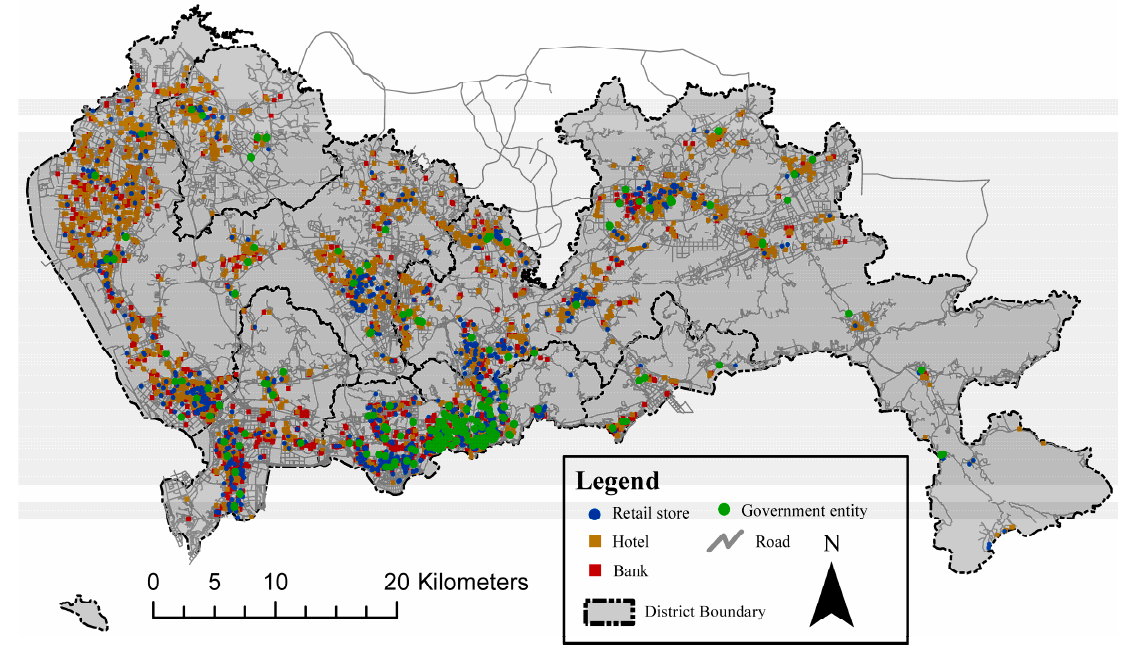
Figure 5. The study region (Shenzhen, China) and datasets.